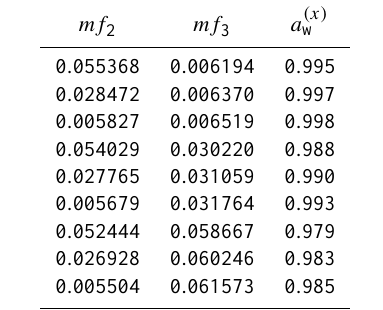
Table A7. Bulk water activity measurements of the system water